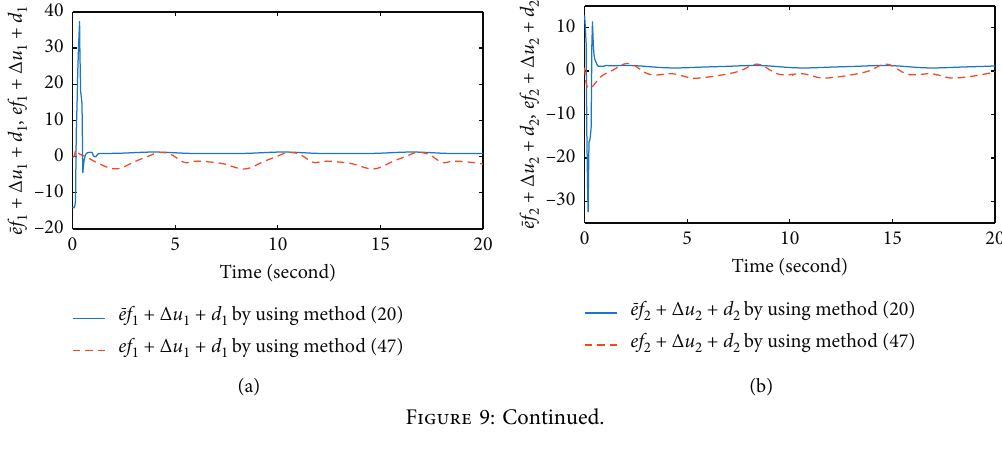
) by using method (21). 3